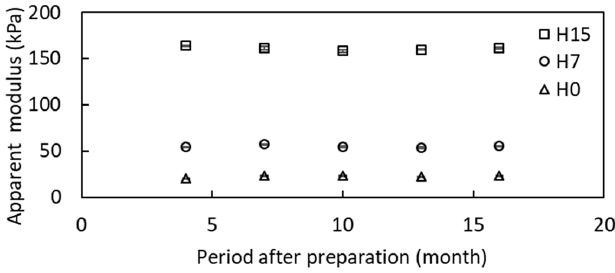
Figure 2. Apparent modulus of urethane gel for artificial tongue. Error bars represent standard errors of 2–7 samples.